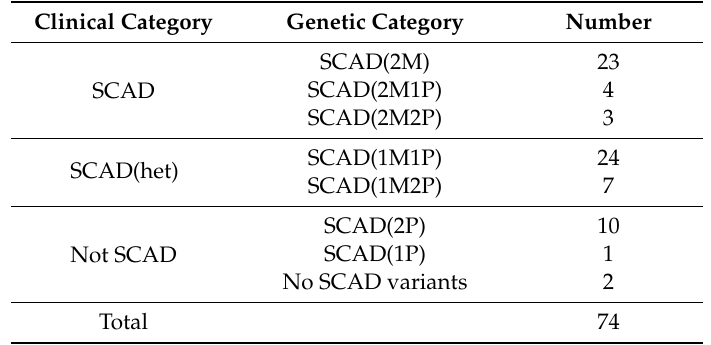
Table 1. Results of ACADS sequencing applied to the short-chain acyl-CoA dehydrogenase (SCAD)